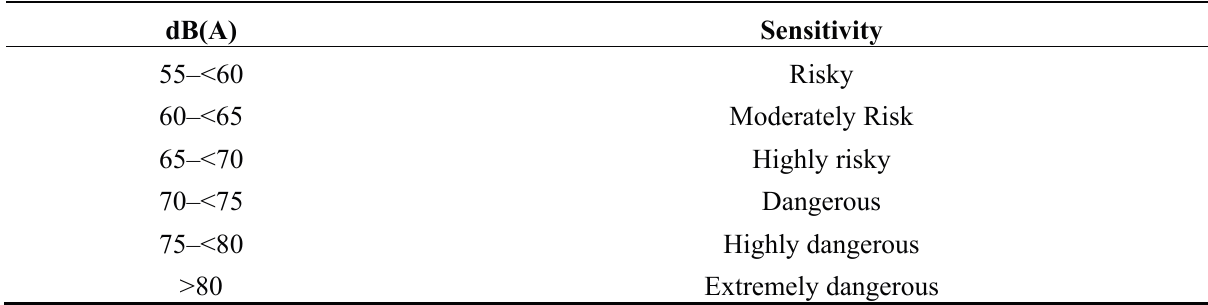
Table 2. Noise sensitivity zones